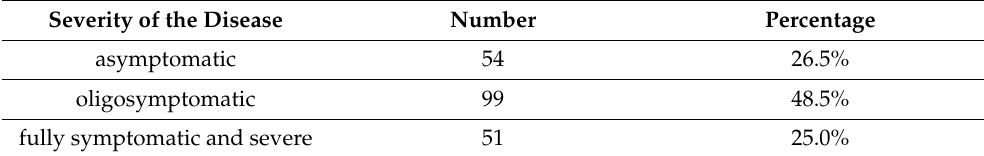
Table 3. Severity of symptoms.